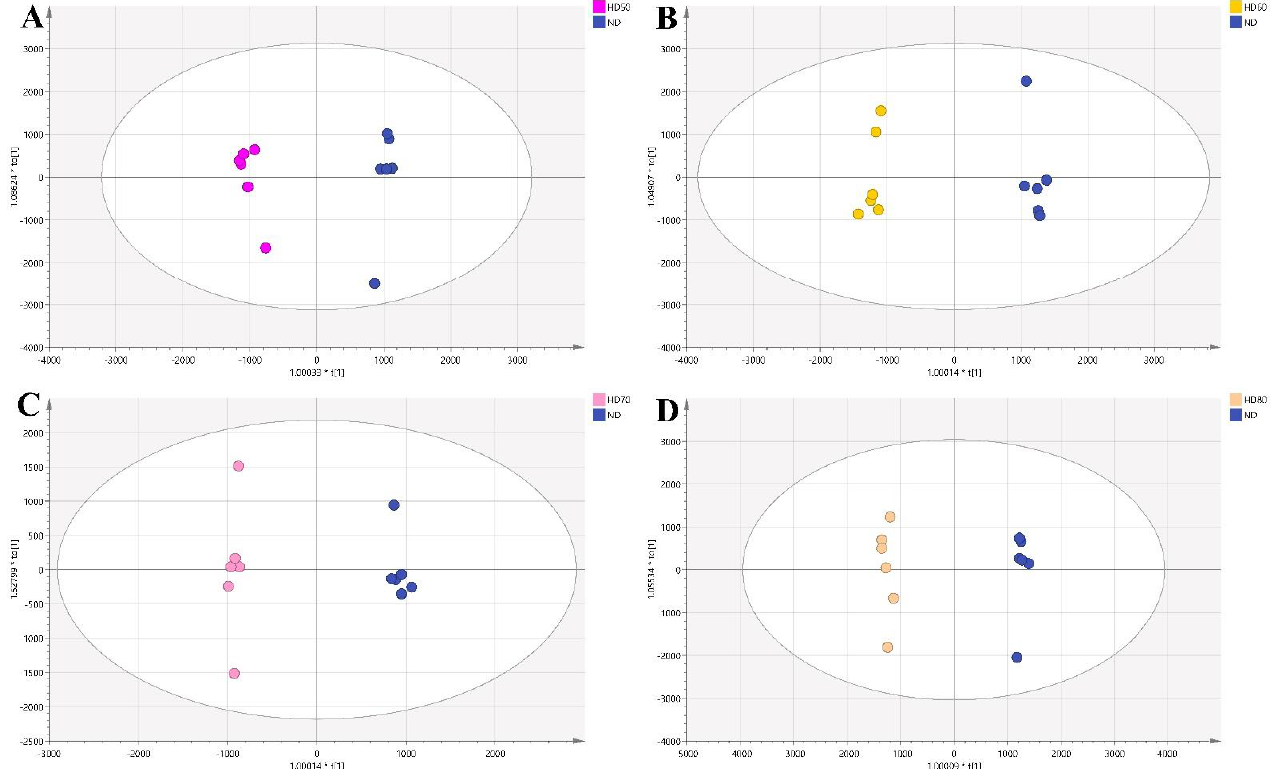
Figure 4. The OPLS − -DA scores plot for comparisons between the different temperatures of hot air drying (HD) and nat- ural drying (ND) ( n = 6): ( A ) for HD50 and ND, ( B ) for HD60 and ND, ( C ) for HD70 and ND, ( D ) for HD80 and ND.